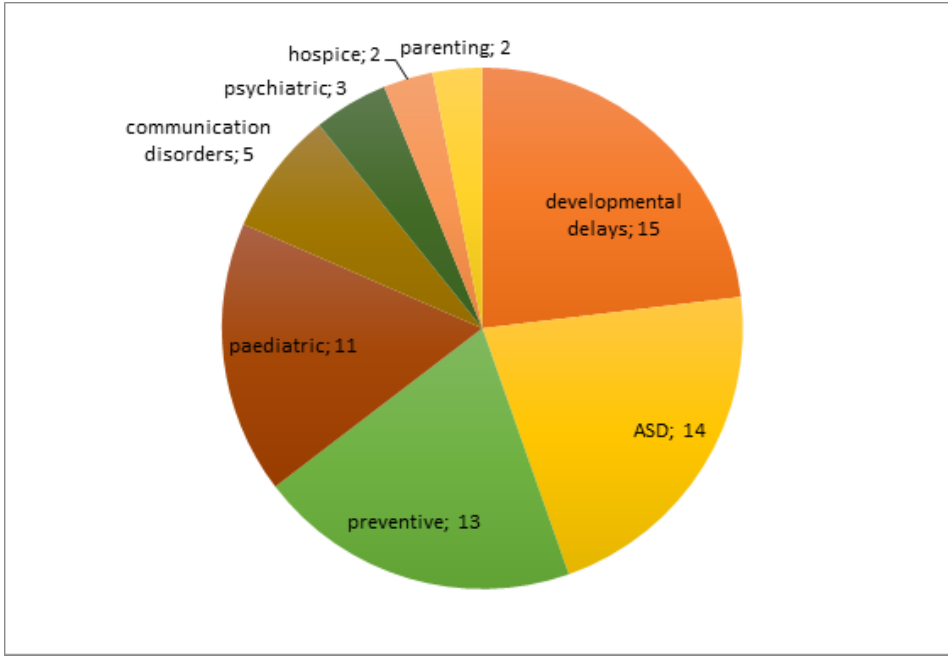
FFigigururee 99.. CClientlient grgroupsoups inin rreseeseararchch